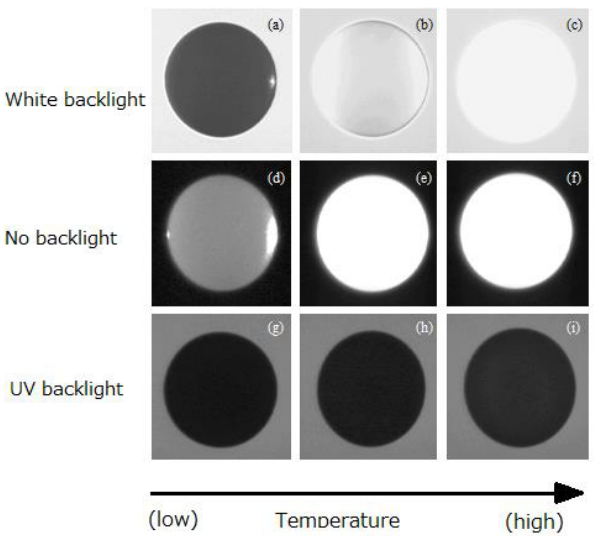
Figure 6. Effects of the background on the sharpness of a sample at several temperatures [21]. A Zr sample at different temperatures (300 K, 1500 K, 2500 K from left to right) for a white back light ( a–c ), no back light ( d–f ), and a UV background illumination ( g–i ).